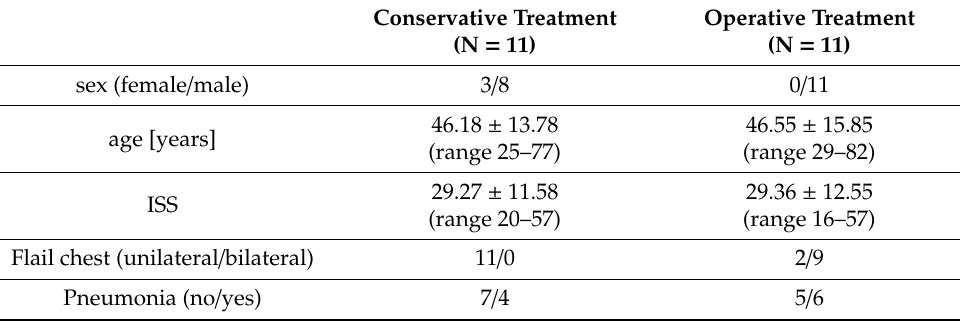
Table 2. Demographic overview of the case-control matched